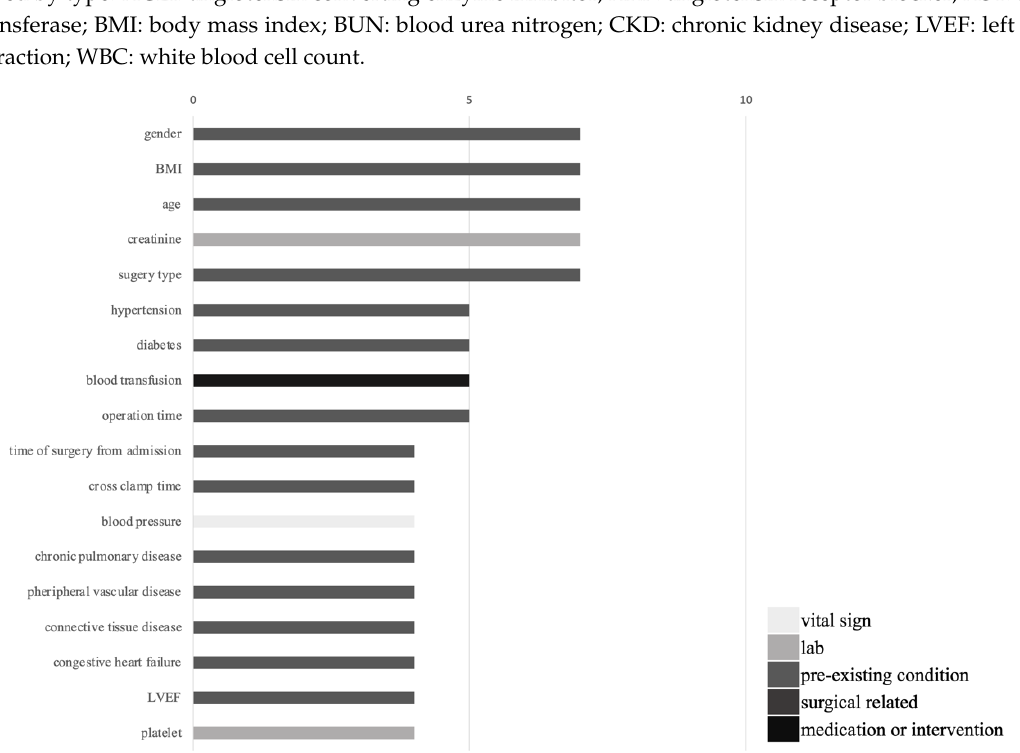
Figure 2. Covariates are most commonly used in machine-learning prediction models in enrolled surgical studies. The covariates are grouped by type. BMI: body mass index; LVEF: left ventricle ejection fraction.